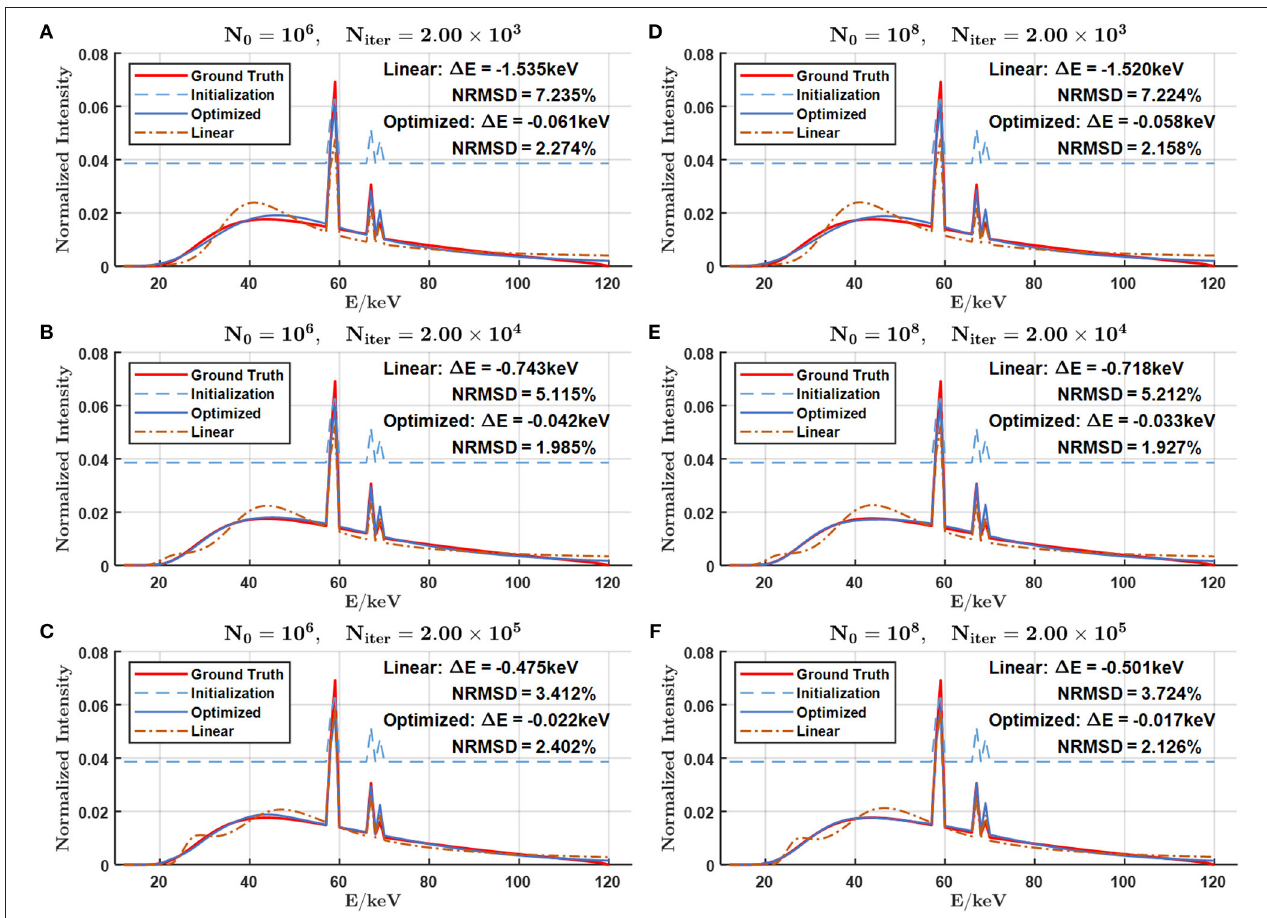
FIGURE 9 | Spectrum estimations from M 15 optimally arranged thicknesses against M 50 conventional linearly arranged thicknesses through N iter iterations = = under two noise levels characterized by N 0 , (A) N 0 10 6 , N iter 2.00 10 3 , (B) N 0 10 6 , N iter 2.00 10 4 , (C) N 0 10 6 , N iter 2.00 10 5 (D) N 0 10 8 , = = × = = × = = × = N iter 2.00 10 3 , (E) N 0 10 8 , N iter 2.00 10 4 , and (F) N 0 10 8 , N iter 2.00 10 5 . The initialization is shifted upward by 0.03 for better visibility. The mean = × = = × = = × energy difference and the NRMSD of the estimated spectra against the ground truth are included. TABLE 3 | Optimal thickness arrangements for M 5 measurements with each of the material types including Al, PMMA, Cu, and Fe, as well as one exemplary = arrangement with the combination of four materials yielding a smaller condition number. Material Thickness, unit: cm Condition